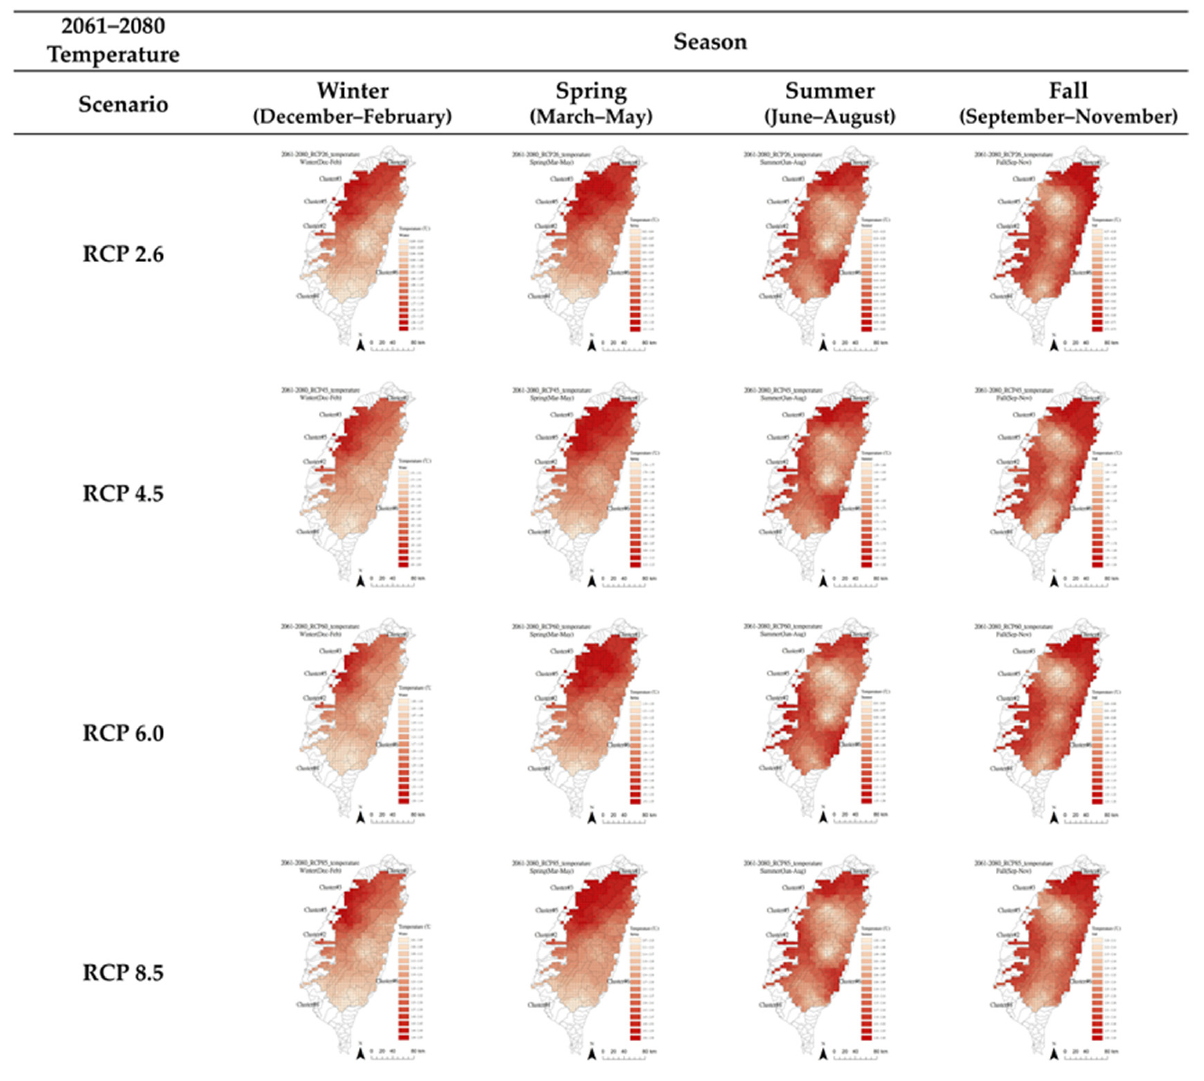
Figure A11. Spatial distribution of simulated temperature data from 2061–2080 for four seasons under different climate change scenarios.